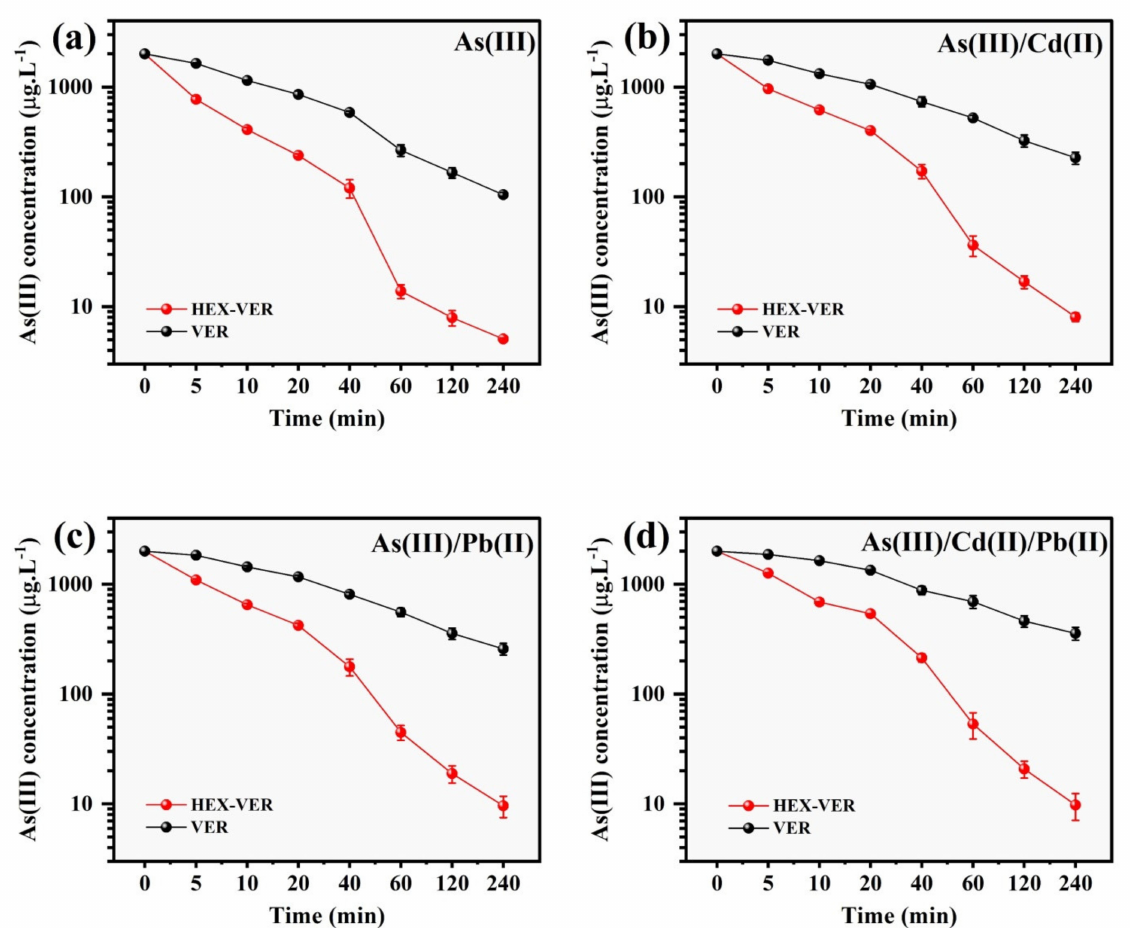
Figure 7. Effect of contact time and kinetic study of As(III) singular ( a ), in the presence of Cd(II) ( b ), in the presence of Pb(II) ( c ), and in the presence of Cd(II)/Pb(II) ( d ) on VER and HEX–VER in Pearl River delta water (As(III) at C i = 2000 µ g · L − 1 ; Cd(II) and Pb(II) both C i = 4000 µ g · L − 1 ; contact time: 240 min; temperature: 30 ◦ C; pH: 7.26 (natural as it was); adsorbent dosage: 1.0 g · L − 1